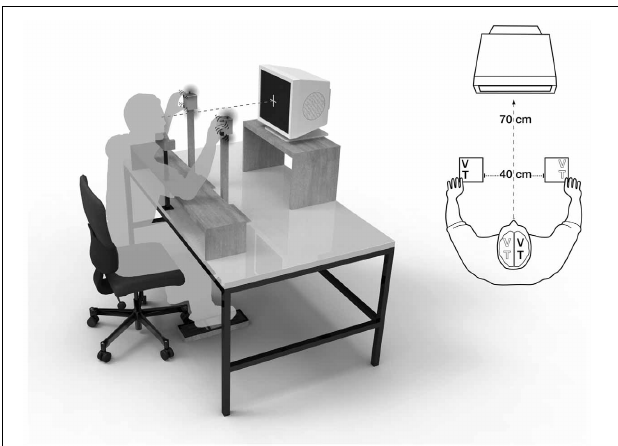
FIGURE 1 | Visuotactile crossmodal congruency task with uncrossed hands. A central fixation cross was displayed at a distance of 70cm, the distance between hands was 40cm. V, visual distractor; T, tactile target.